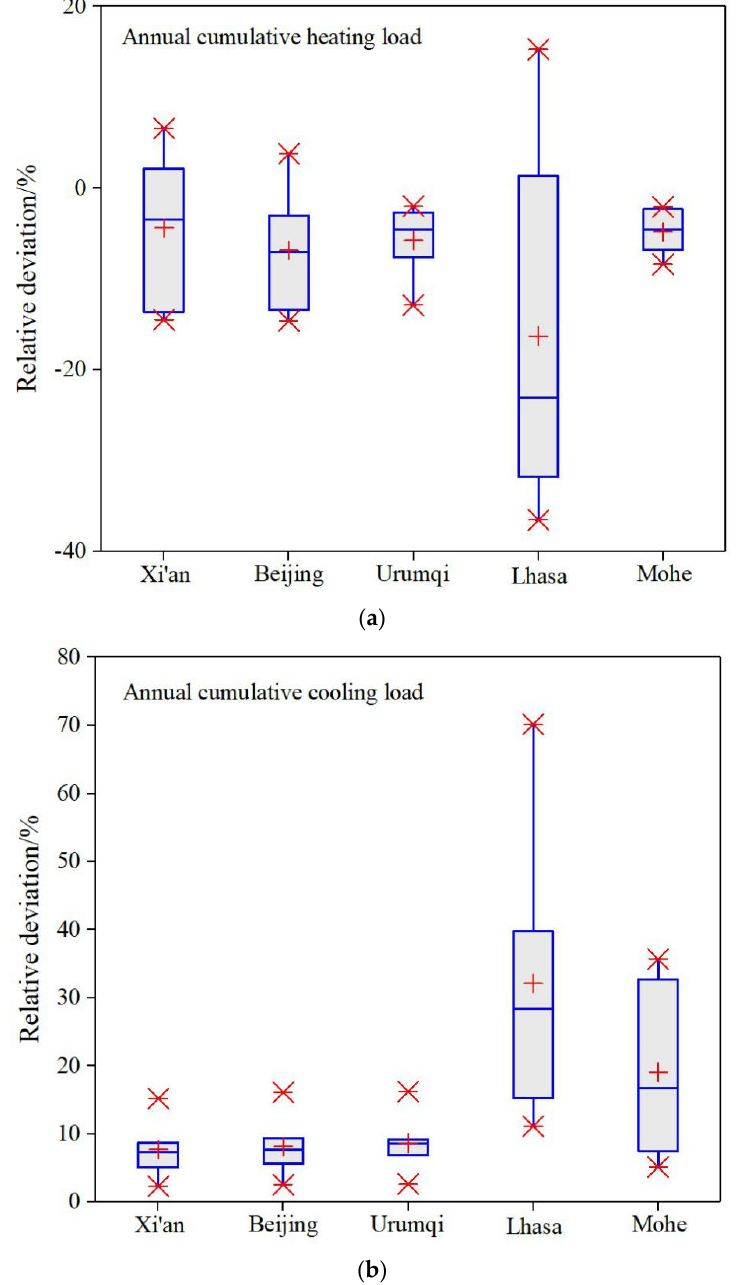
Figure 12. Boxplots showing the relative deviations in the annual cumulative heating and cooling loads with different SHTCs: ( a ) Annual cumulative heating loads; ( b ) Annual cumulative cooling loads.